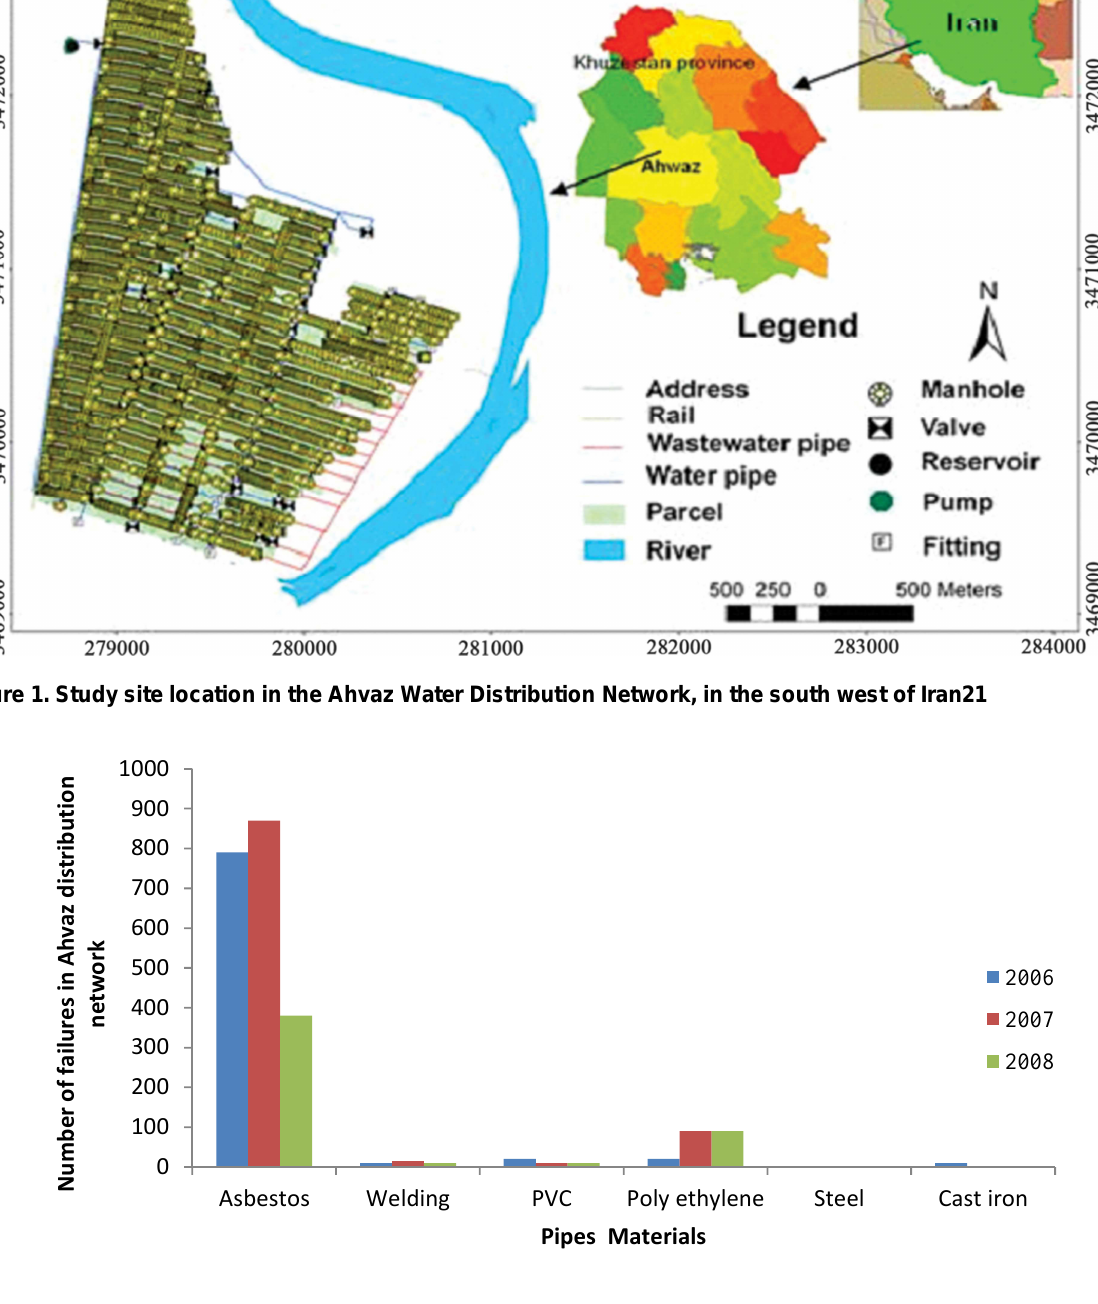
Figure 2. Number of failures in Ahvaz, Iran distribution network based on type of the pipe during 2006-2008 PVC: Polyvinyl